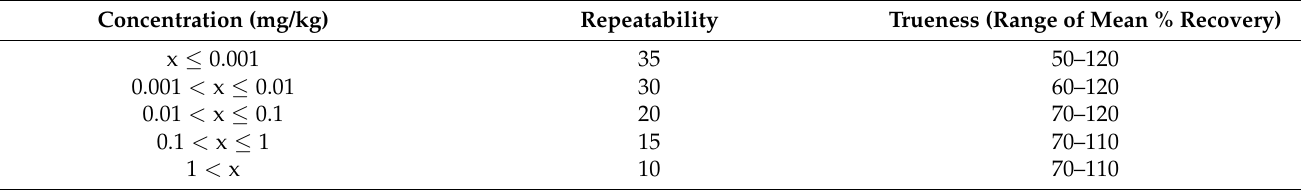
Table 6. In-laboratory method validation criteria for analysis of pesticide